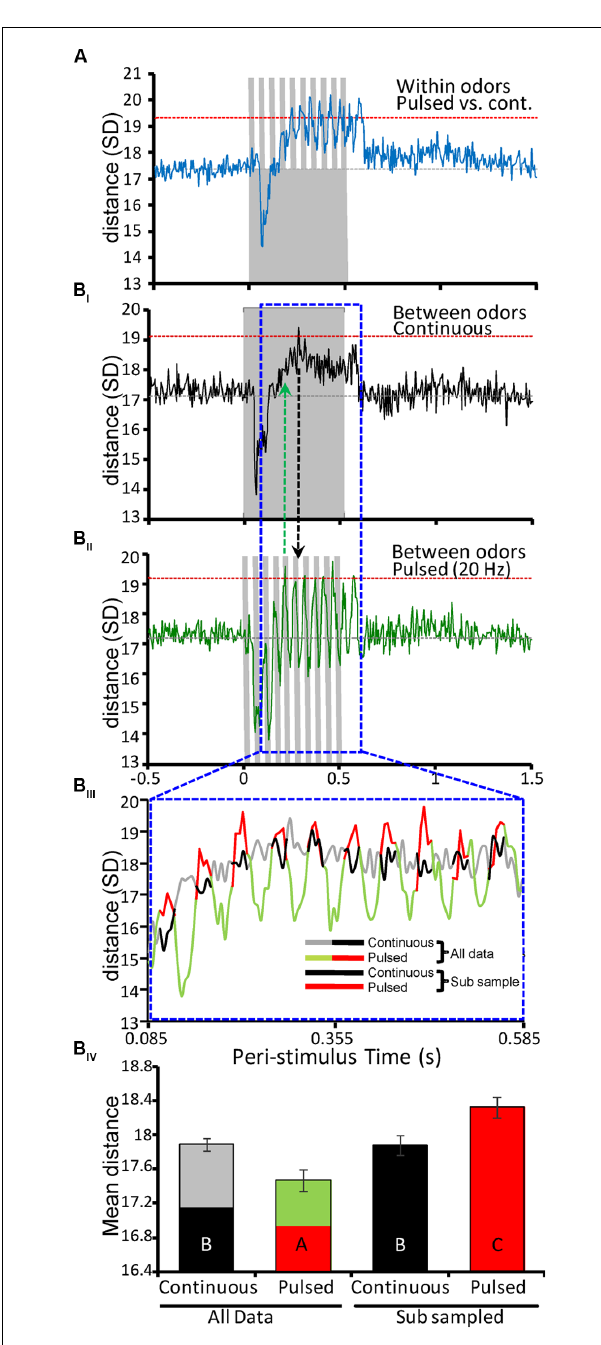
FIGURE 5 |Antennal lobe odor representations are more distinct when odor is pulsed. (A) Mean within-odor Euclidean distance (ED) between comparisons of population responses elicited by the same odor presented as either 20 Hz pulse trains or as continuous stimuli. All stimuli were 500 ms in duration (inset gray bars). Analysis was performed on individual stimulus repeats using a 5 ms binning window and results were then averaged across repeats for all odors ( N = 10 per odor/stimulation protocol). Results are based on the entire population of recorded units ( N = 150). Inset gray horizontal line represents the mean spontaneous ED value. Inset horizontal red lines represent ± 2 standard deviations (SDs) from that mean distance